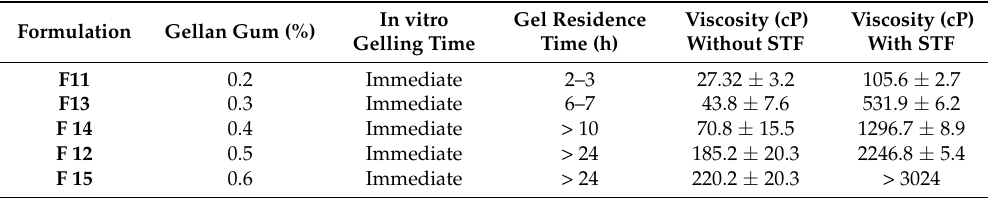
Table 3. Rheological properties of triamcinolone acetonide loaded solid lipid nanoparticle in situ gels (mean ± SD, n =